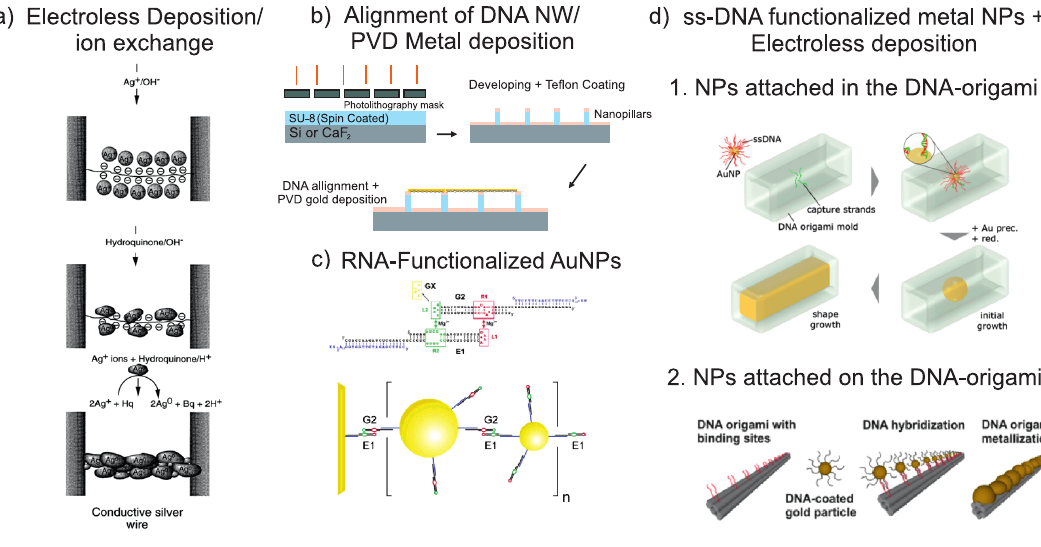
Figure 1. ( a ) conductive silver nanowire construction. Oligonucleotides attached to the gold electrodes and silver ions loaded to the oligonucleotides by Ag + /Na + ion exchange. Wire developed using citrate solution and silver ions. Image taken with permission from [12]; ( b ) PVD deposition of metal on aligned DNA. The DNA is suspended on superhydrophobic pillars made from SU-8 resist by lithography; ( c ) RNA-functionalized nanoparticles (NPs) for the creation of conducting nanowires (NWs). The illustration shows the sequential assembly of AuNPs with diameters of 30 and 15 nm in diameter, and the controlled assembly of gold nanoparticle clusters connected to electrodes through RNA–RNA interactions. E1 and G2 are RNA hairpin molecules which interact through loop-receptor interactions L1–R1 and L2–R2. GX is a control RNA. Taken with permission from [41] ( d ) 1. DNA Origami molds filled with Au, with permission from [42]. 2. Nanoparticles NPs attached to six-helix bundles and subsequently enhanced. Taken with permission from